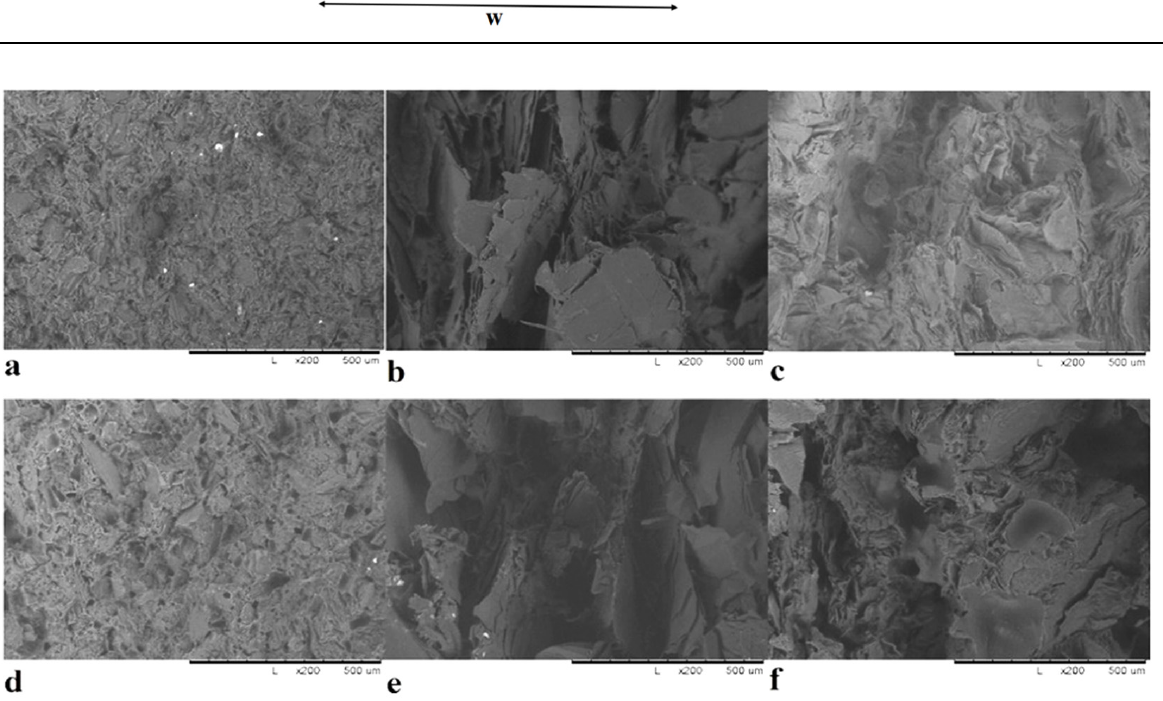
Figure 5. SEM micrographs of: polysulfone (PSU) + 50 wt.% AG ( a ); PSU + 50 wt.% NG ( b ); PSU + 50 wt.% EG ( c ); PSU + 70 wt.% AG ( d ); PSU + 70 wt.% NG ( e ); PSU + 70 wt.% EG ( f ).